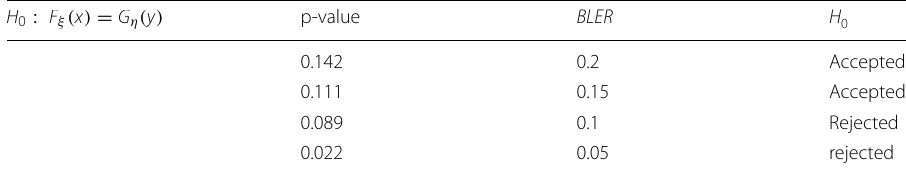
Table 2 Correlation PESQ versus HARQ RTT H 0 : F ξ ( x ) = G η ( y